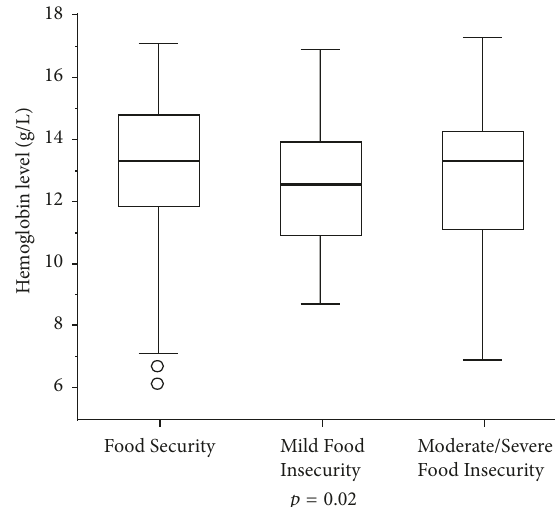
Figure 1: Hemoglobin level and household food insecurity status. Taubat´e, S˜ao Paulo, Brazil,